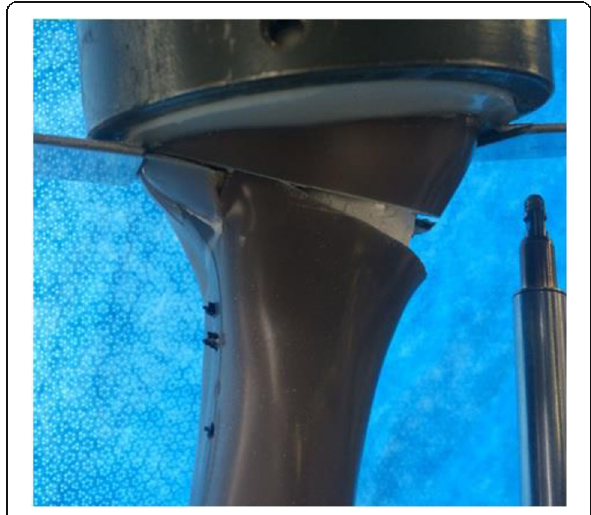
Fig. 3 Example of lateral cortex fracture and osteotomy collapse